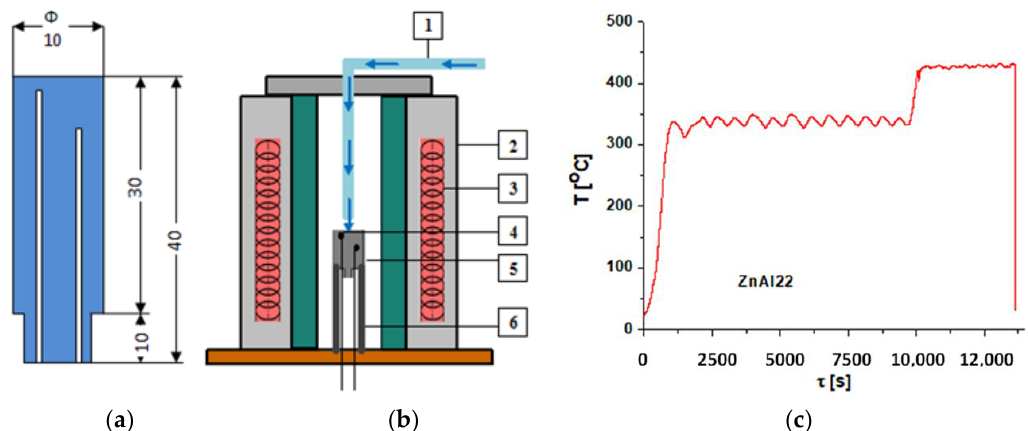
Figure 1. Set-up of the tool used for thermal treatment: ( a ) shape and dimensions of the samples submitted to thermal treatment; ( b ) device used for the thermal treatment: 1—cooling system using water; 2—furnace; 3—electrical resistance; 4—thermocouple; 5—sample; 6—sample holder; ( c ) thermal treatment parameters.